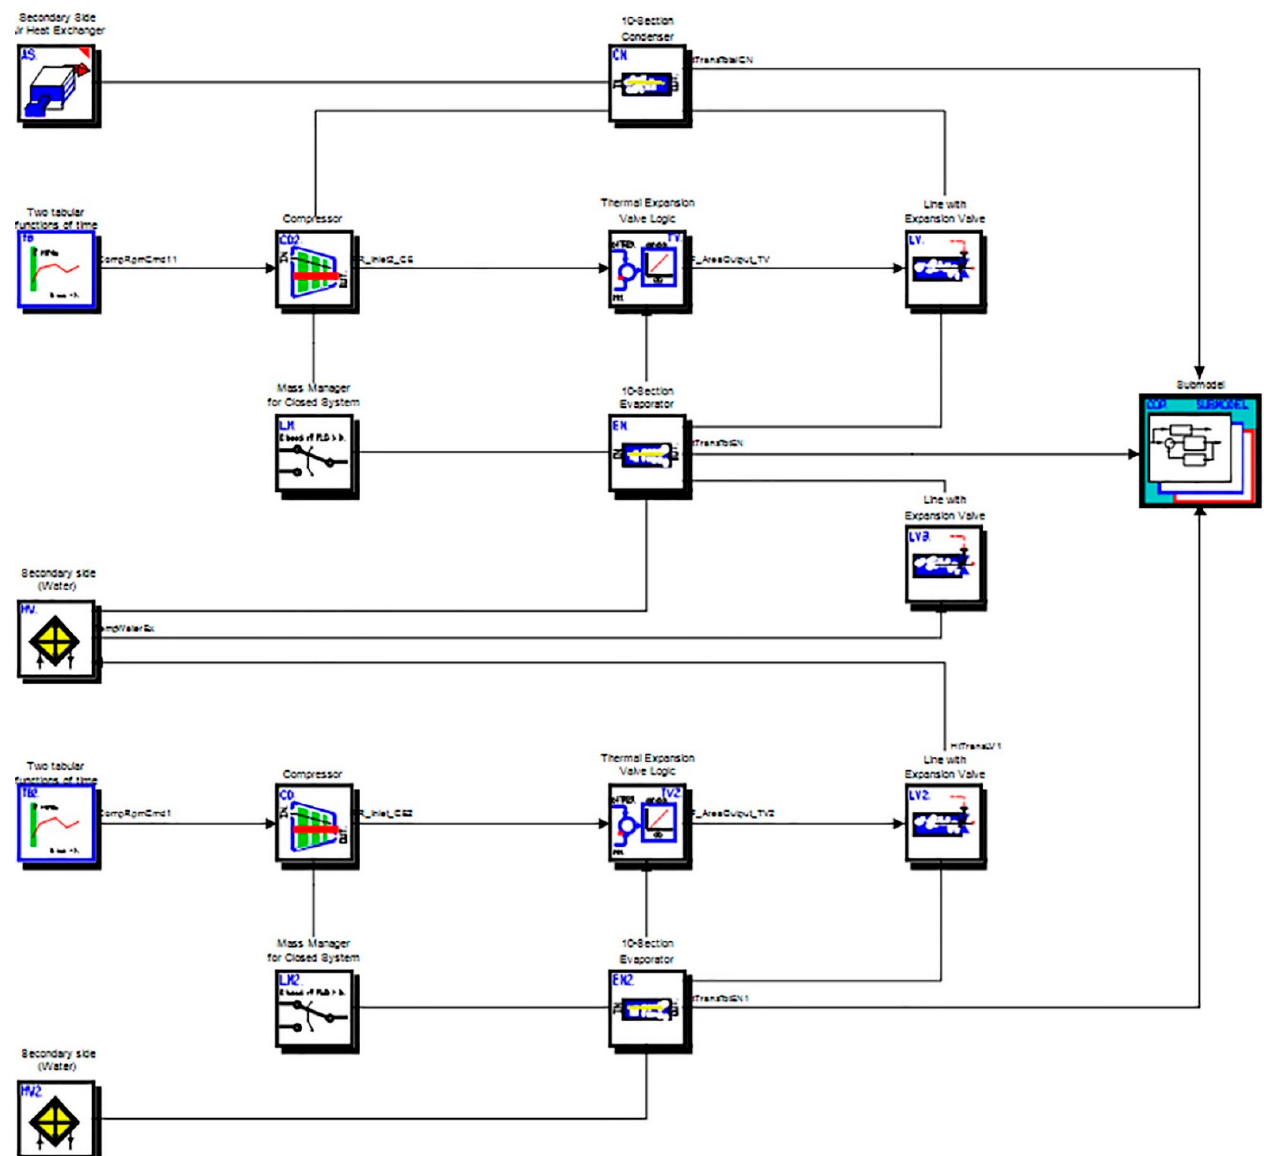
Figure 2. Functional diagram of temperature control in heart-lung machine’s heat exchanger in the MSC Easy5 system.